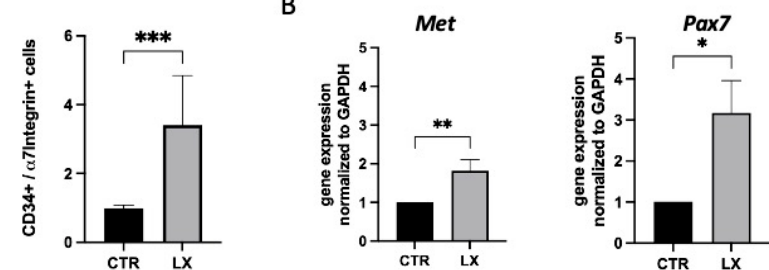
Figure 6. Perinatal SPL inhibition expands the endogenous satellite cell (SC) population. ( A ) Flow cytometry quantification of SCs isolated from disaggregated muscles ( gastrocnemius ) of control (CTR, n = 8) and LX2931-treated (LX, n = 4) mdx pups. Cells were stained using five selected antibodies. Results were analyzed using FlowJo software. Cells were considered to represent SCs if they were positive for CD34 and a7 integrin and negative for CD31, CD45 and Sca-1. Mean ± SD; *** p < 0.005. ( B ) Gene expression of SC markers Pax7 and Met were detected by qRT-PCR and normalized to Gapdh . n = 4–5/group, and each sample was run in triplicate. Mean ± SD; * p < 0.05, ** p